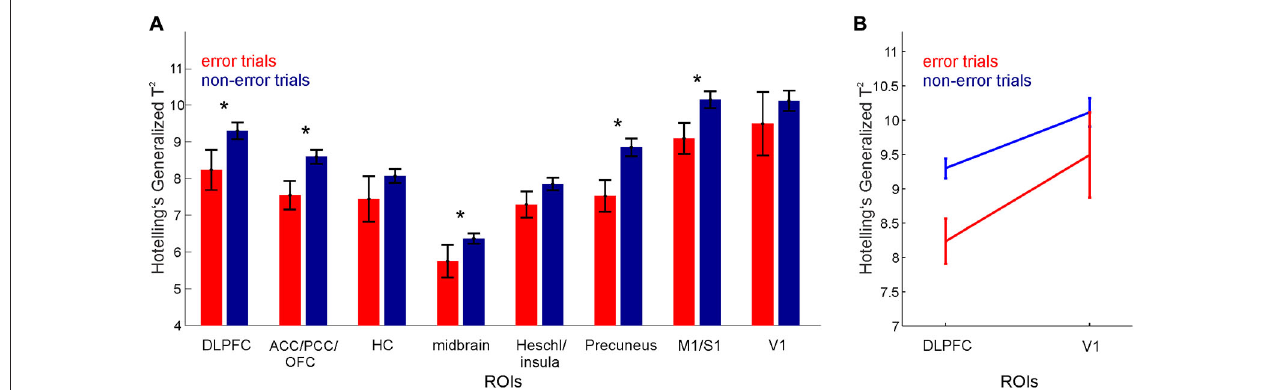
FIGURE 3 | Error processing. Hotelling’s Generalized T 2 for error vs. non-error trials for (A) various ROIs. Note that the midbrain ROI result represents the average of the test statistics for midbrain masks (dorsal and ventral striatum, and VTA). (B) DLPFC and V1. Error bars, SEM across grouped trials for all